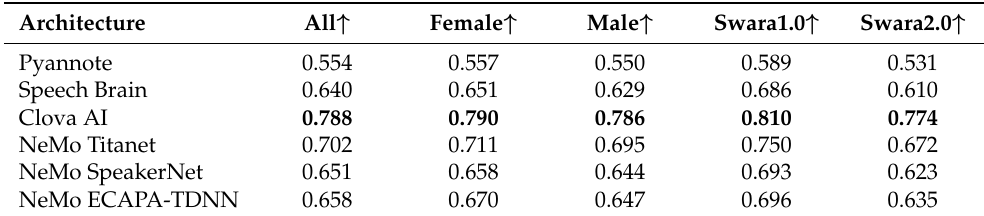
Table 2. Average intra-speaker cosine similarity across the different speaker embedding architectures and different speaker subsets. Arrows mark the direction of best performance. Best results are highlighted in boldface.